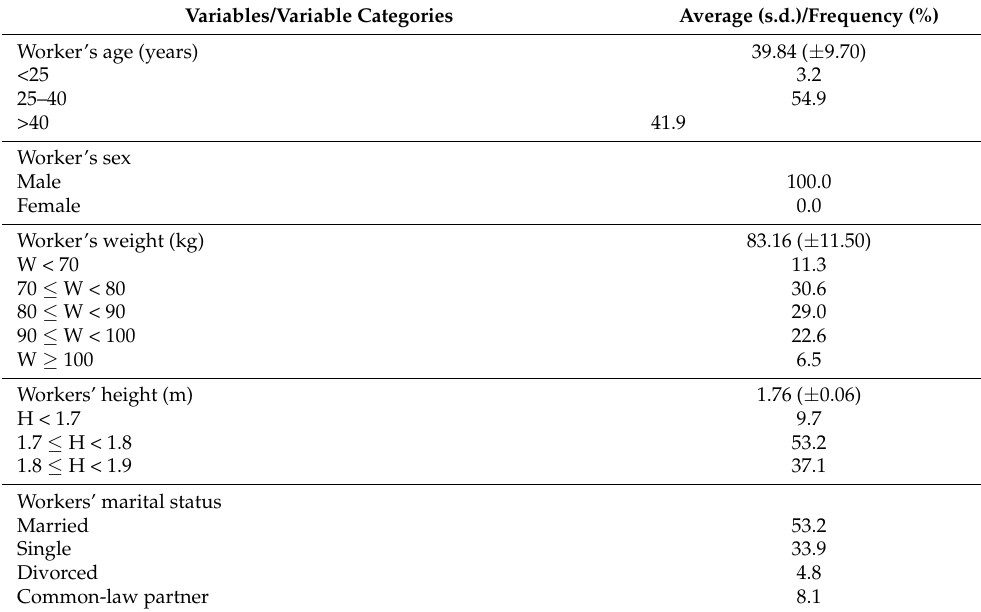
Table 2. Descriptive parameters of company workers variables (average (s.d.) and